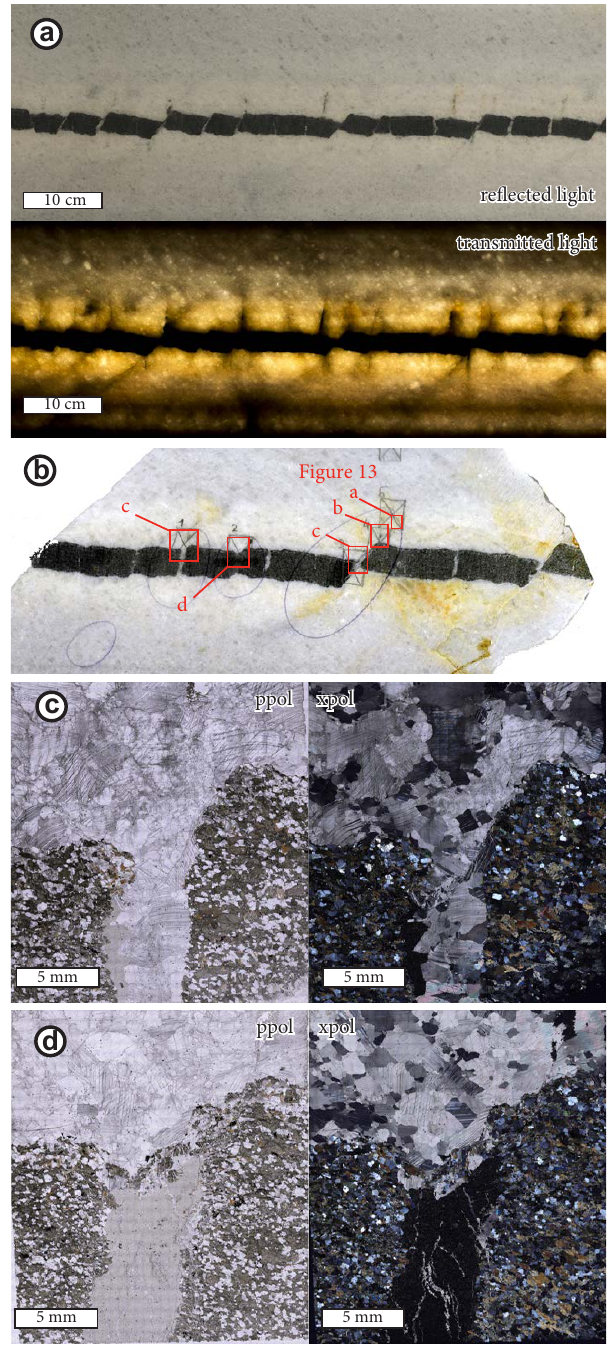
Figure 12. (a) Domino and torn boudins in a polished, 2cm thick plate of marble. Close to the amphibolite layer the marble is more translucent. The transmitted light image highlights the shear zones extending from the domino boudins into the marble where they curve and splay. (b) Overview of thin-section locations of ( c , d ) and Fig. 13. The amphibolite layer is the same as shown in (a) . (c) This torn boudin neck is filled mostly with calcite and contains a chlorite rim. Large grain size indicates that torn boudin necks form primarily as veins and not by intrusion of the surrounding marble. (d) Torn boudin neck filled with chlorite containing small calcite-filled veinlets.